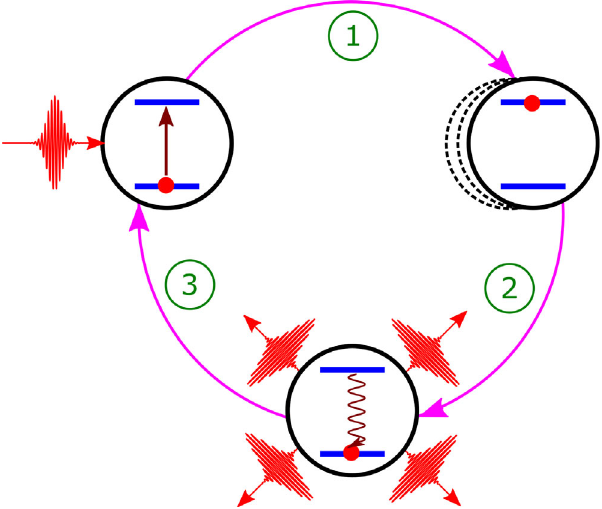
FIG. 1. Schematic diagram of optical cycling in an ideal two- level system. Repetition of steps 1 – 3 is required to achieve radiative laser cooling: (1) directional photon absorption, (2) iso- tropic spontaneous emission, and (3) decay to the initial quantum level. The complex structure of molecules can interrupt this cycle, e.g., by the addition of multiple decay pathways during step